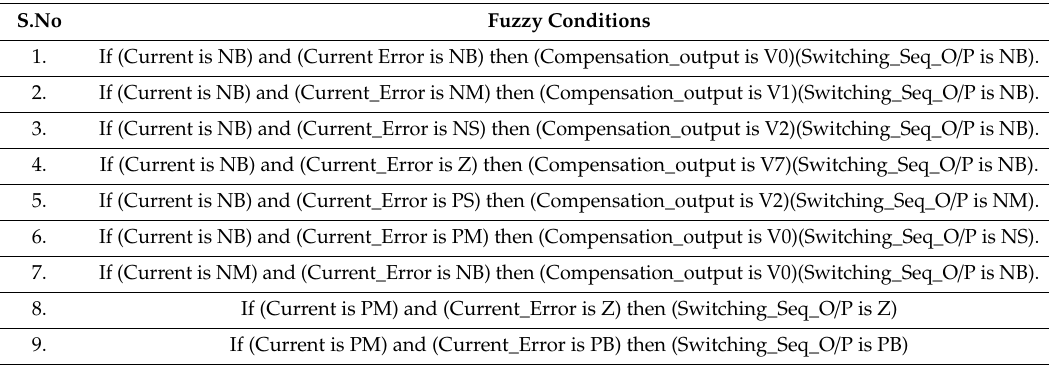
Figure 6. Outline of the validated fuzzy controller. Table 1. Fuzzy Rules for obtaining the current compensation output and the switching